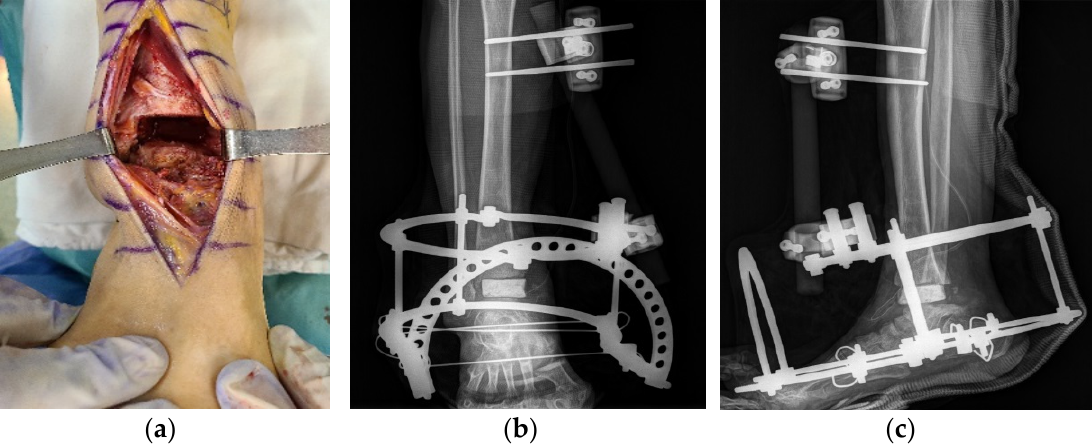
Figure 6. Intraoperative gross photograph showing open arthrotomy of the ankle joint with extensive debridement of infected tissue ( a ). Plain anteroposterior ( b ) and lateral radiographs ( c ) taken after the first stage showing insertion and fixation of a vancomycin polymethylmethacrylate spacer with an external fixator.